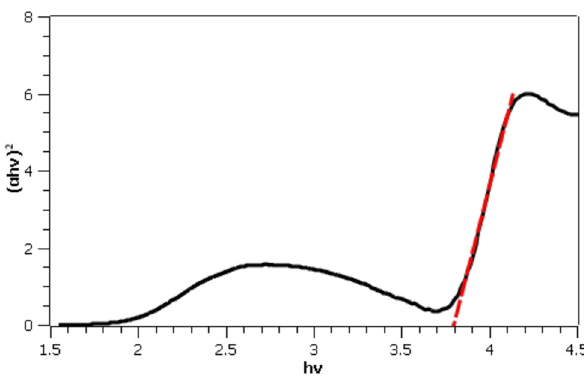
Figure 6: The bandgap estimation for the spectrum of the sample exposed to direct sunlight, and see the UV - Vis spectrum in Figure 5.